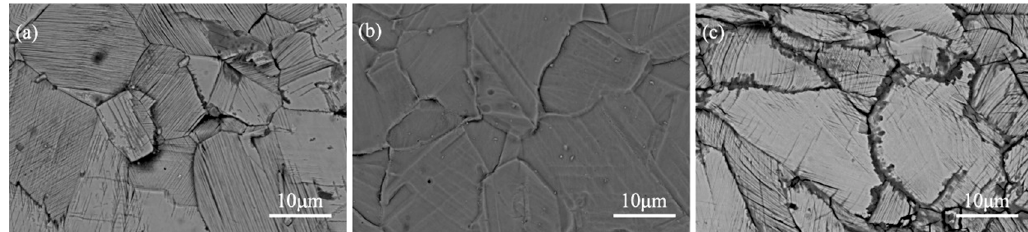
Figure 3. Surface morphologies of the plasma-nitrided coating under different bias voltages: ( a ) − 400 V, ( b ) − 500 V, ( c ) − 600 V.